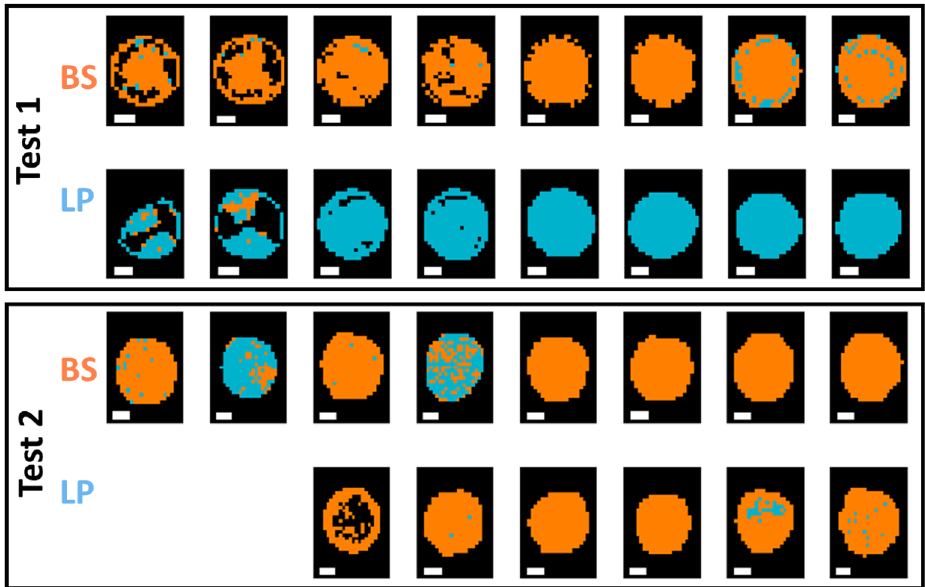
Figure 6. Classification maps for samples in the test set (reps 6, 9, 12, and 16) obtained from the best pixel- level FTIR models for GP species BS/LP classification. Pixels classified as BS/LP are shown in orange or blue respectively. Each replicate has two drops. BS: Bacillus subtilis ; LP: Lactobacillus plantarum. White scalebar indicates 1 mm (width) × 0.2 mm